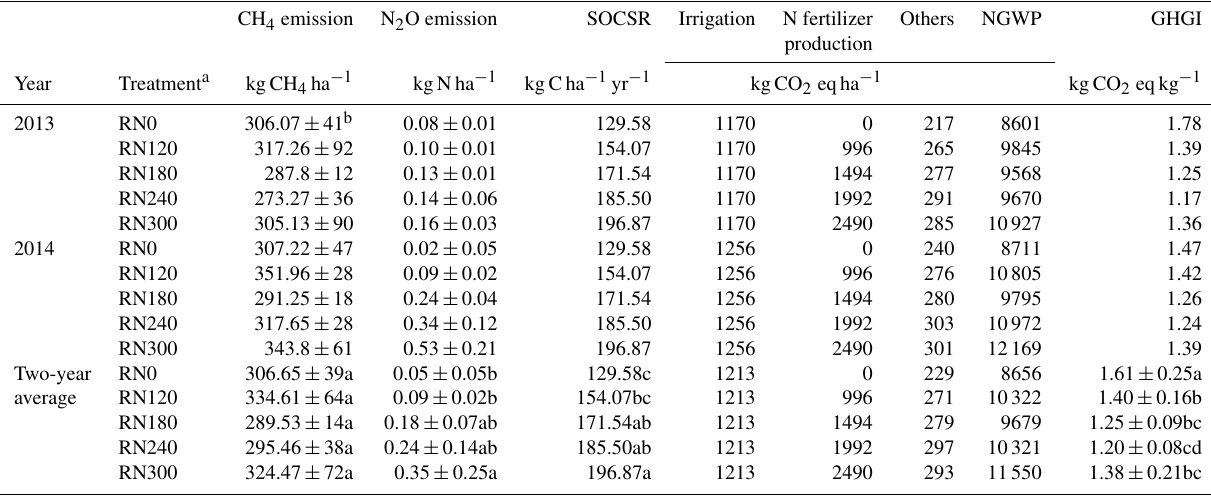
Table 4. The net global warming potential (NGWP) and greenhouse gas intensity (GHGI) for the two rice-growing seasons from 2013 to 2014 in the Taihu Lake region.